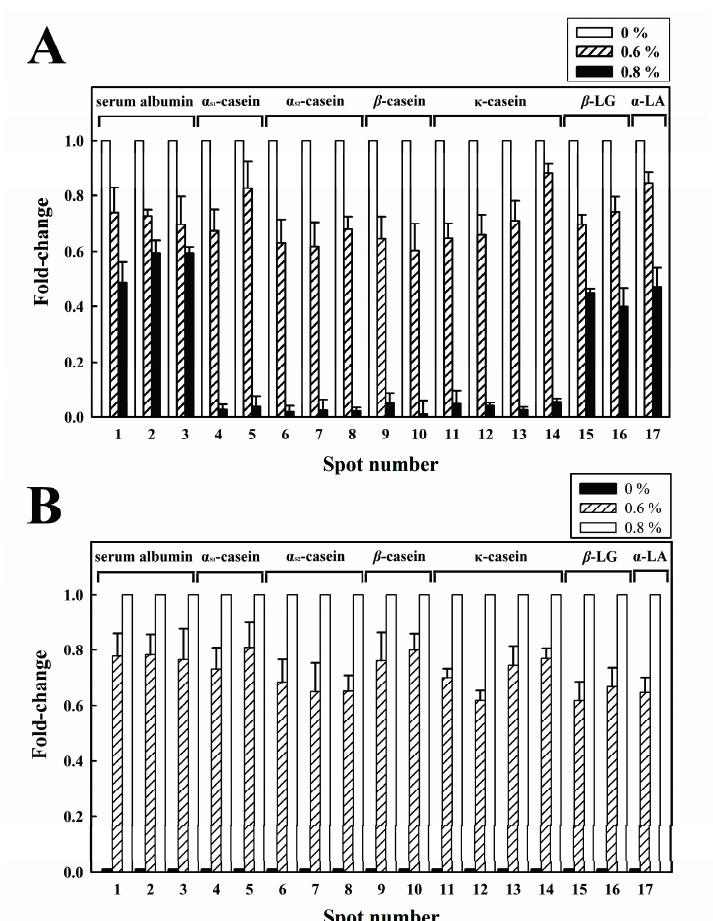
Figure 5. Relative abundance of milk protein spots after treatment with different concentrations of chitosan (0%, 0.6%, or 0.8%) at 30 °C for 1 h. ( A ) milk supernatant fraction; ( B ) milk pellet fraction. Histograms show the fold changes of the protein spots, which were determined using the Samespots software